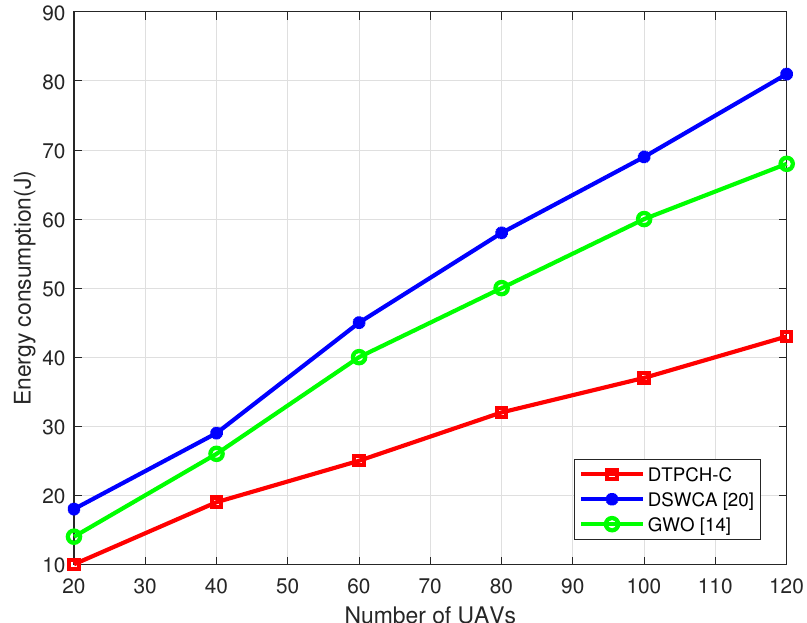
Figure 9. Energy consumption of different clustering schemes versus the number of UAV